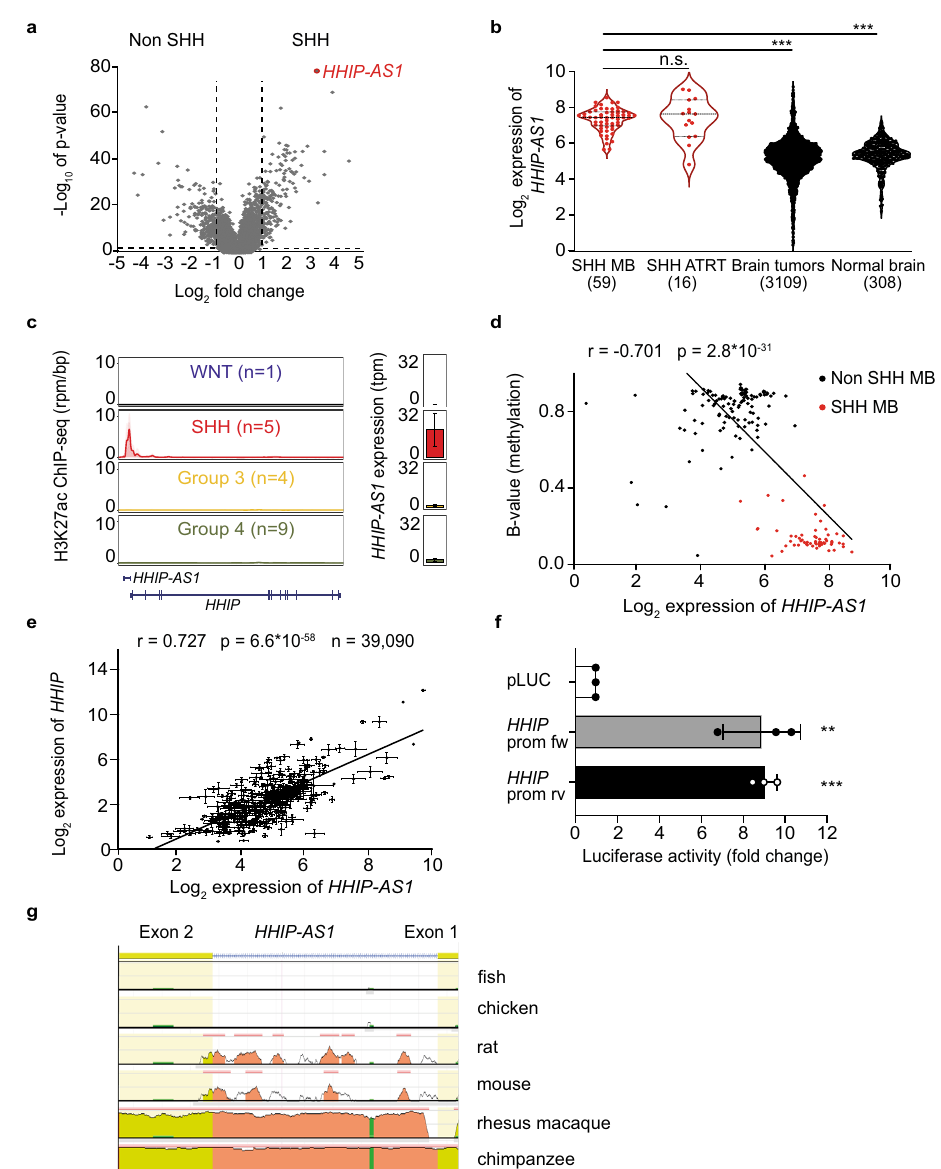
Fig. 1 The long non-coding RNA HHIP-AS1 is a hallmark of human SHH-driven tumors. a Long non-coding RNA (lncRNA) expression pro fi les in SHH- driven medulloblastoma (MB; right side) versus non SHH-driven MB (left side). The volcano plot illustrates the distribution of statistical signi fi cance ( y - axis) and relative expression level ( x -axis) for the lncRNAs pro fi le. The red dot indicates HHIP-AS1 ( HedgeHog Interacting Protein-Anti-Sense 1 ). Statistical analysis was performed using one-way ANOVA with post-hoc Tukey HSD; *** p < 0.001. b Violin plots display the expression level of HHIP-AS1 according to an integrative transcriptomic analysis of 3492 samples from neoplastic brain tissues with SHH activation (SHH MB and atypical teratoid/rhabdoid tumors (ATRT)) or without commonly reported SHH activation (brain tumors) and normal brain without tumor. Statistical analysis was performed using Kruskal – Wallis Test with Dunn ’ s Multiple Comparison Test; *** p < 0.001. Red dots = SHH-driven entities; black dots = non SHH-driven tumors and control tissue. c H3K27ac ChIP-sequencing pro fi le on HHIP-AS1 and HHIP loci in the four MB subgroups 64 . Bar graph indicates the expression level of HHIP-AS1 in the corresponding MB subgroups. Error bars represent ± SEM. d Scatter plot representing the degree of DNA methylation (B value) of the potential promoter region in relation to HHIP-AS1 expression levels in SHH MB (red dots) and other MB subgroups (black dots). Statistics were done by Pearson correlation. e Scatter plot displaying expression correlation of HHIP and HHIP-AS1 across datasets ( n = 351). Mean expressions of both transcripts from 39,090 samples were analyzed in their respective datasets and plotted with error bars representing the SEM for both genes. Statistics were done by Pearson correlation. f The bar graph indicates the relative luciferase activity of empty luciferase vector (pLUC) or pLUC containing the cloned HHIP promoter sequence orientation (fw = forward, rv = reversed). The results are presented as the mean ± SD of three independent experiments. Student´s two-sided t -test; ** p < 0.01, *** p < 0.001. g Identi fi cation of evolutionarily conserved regions corresponding to critical regulatory elements in large (>1 Mb), highly conserved gene desert regions fl anking the human HHIP-AS1 gene located at chromosome 4q31.21 with two exons. Source data and exact p -values are provided as a “ Source Data fi le ”